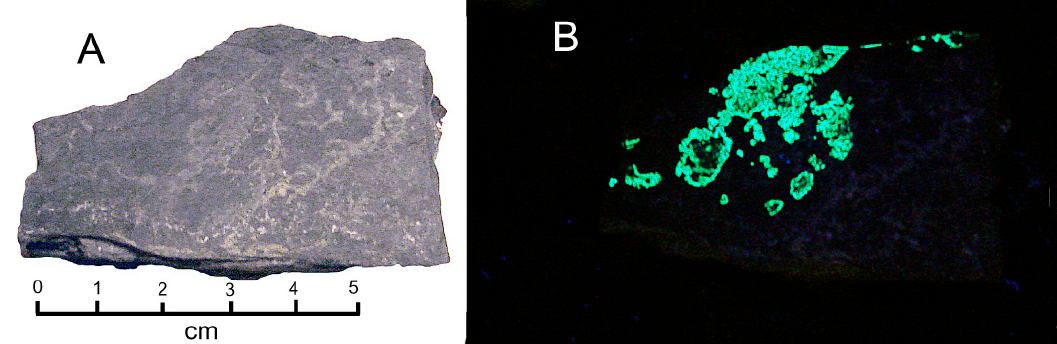
Figure 13. Flat silty surface of White Canyon sample, containing thin coatings of zippeite. ( A ) Ordinary light. ( B ) Fluorescence under short-wave UV light.